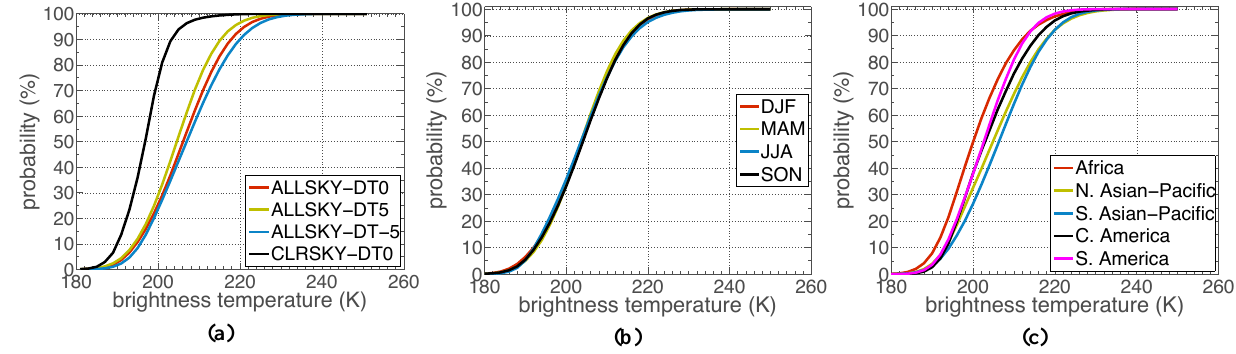
Fig. 6. Cumulative histograms of cloud top brightness temperatures for convective sources that transport air parcels to the 100hPa surface. (a) Results obtained for all-sky and clear-sky conditions, from ensembles ALLSKY- 1T 0, ALLSKY- 1 T5, ALLSKY- 1 T-5 and CLRSKY- 1T 0. (b) Results obtained for all-sky conditions only, from the ALLSKY- 1T 0 ensemble, for trajectories detrained during boreal winter (DJF), spring (MAM), summer (JJA) and fall (SON) seasons. (c) Results obtained for all-sky conditions only, from the ALLSKY- 1T 0 ensemble, for trajectories detrained in the region of Africa, north Asian-Pacific, south Asian-Pacific, central America and South America, designated in Fig.